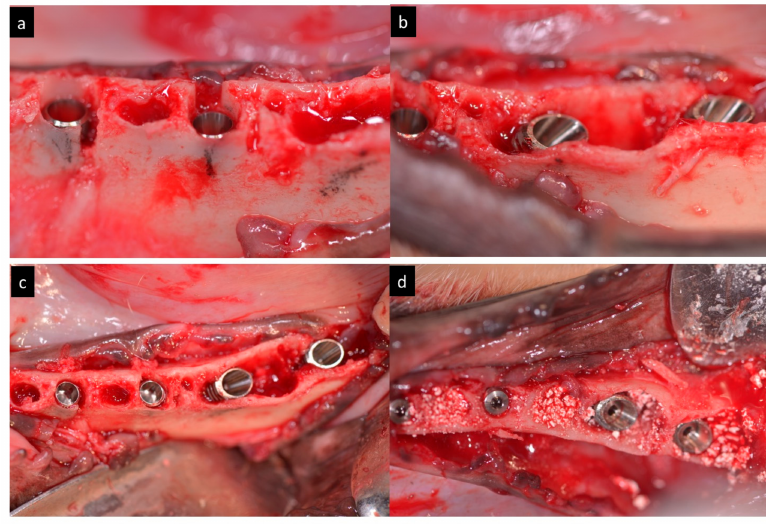
Figure 4. ( a – d ) Clinical view of the immediate implants inserted 1 mm subcrestally in distal roots.